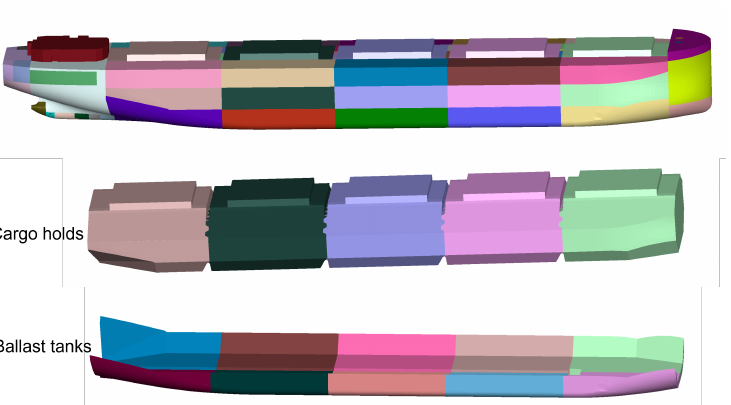
Figure 1. STL model of the hull and compartments of the 59,000 DWT bulk carrier “BAOHANG 56” designed by SDARI in